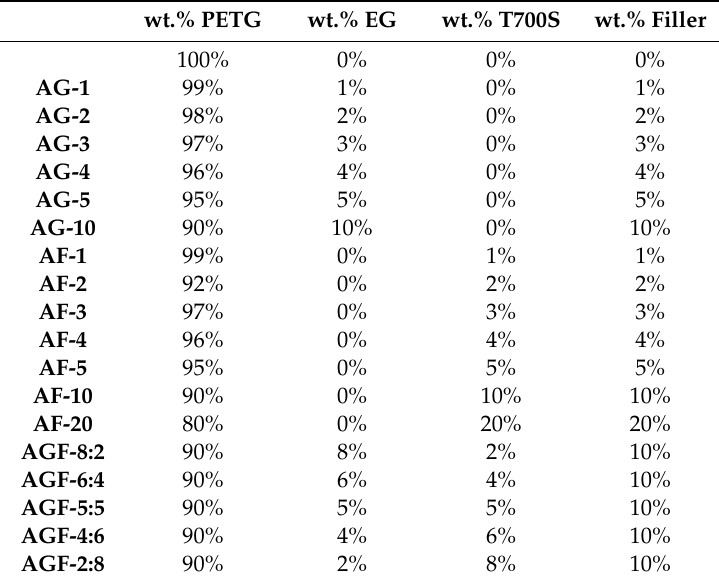
Table 1. Overview of prepared virgin PETG composite materials.